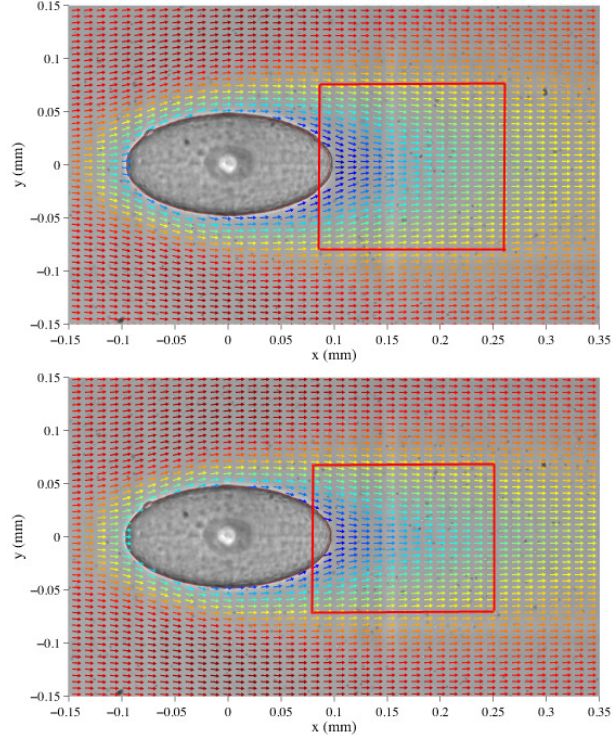
Figure 5. Velocity vector for a fluid flow at the same Re . Newtonian fluid ( up ) and viscoelastic fluid ( down ). Adapted from